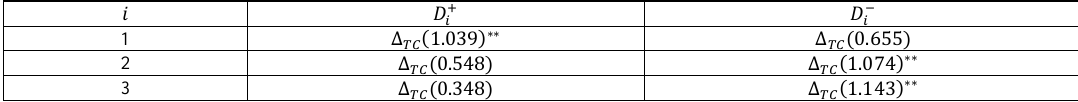
Table 3. Separation measures from Positive ideal solution and Negative ideal solution of three robots for evaluations given in Table 2 using Euclidean distance for interval 2-tuple linguistic variables 𝑖 𝐷 𝑖+ 𝐷 𝑖− 1 ∆ 𝑇𝐶 (1.039) ∗∗ ∆ 𝑇𝐶 (0.655) 2 ∆ 𝑇𝐶 (0.548) ∆ 𝑇𝐶